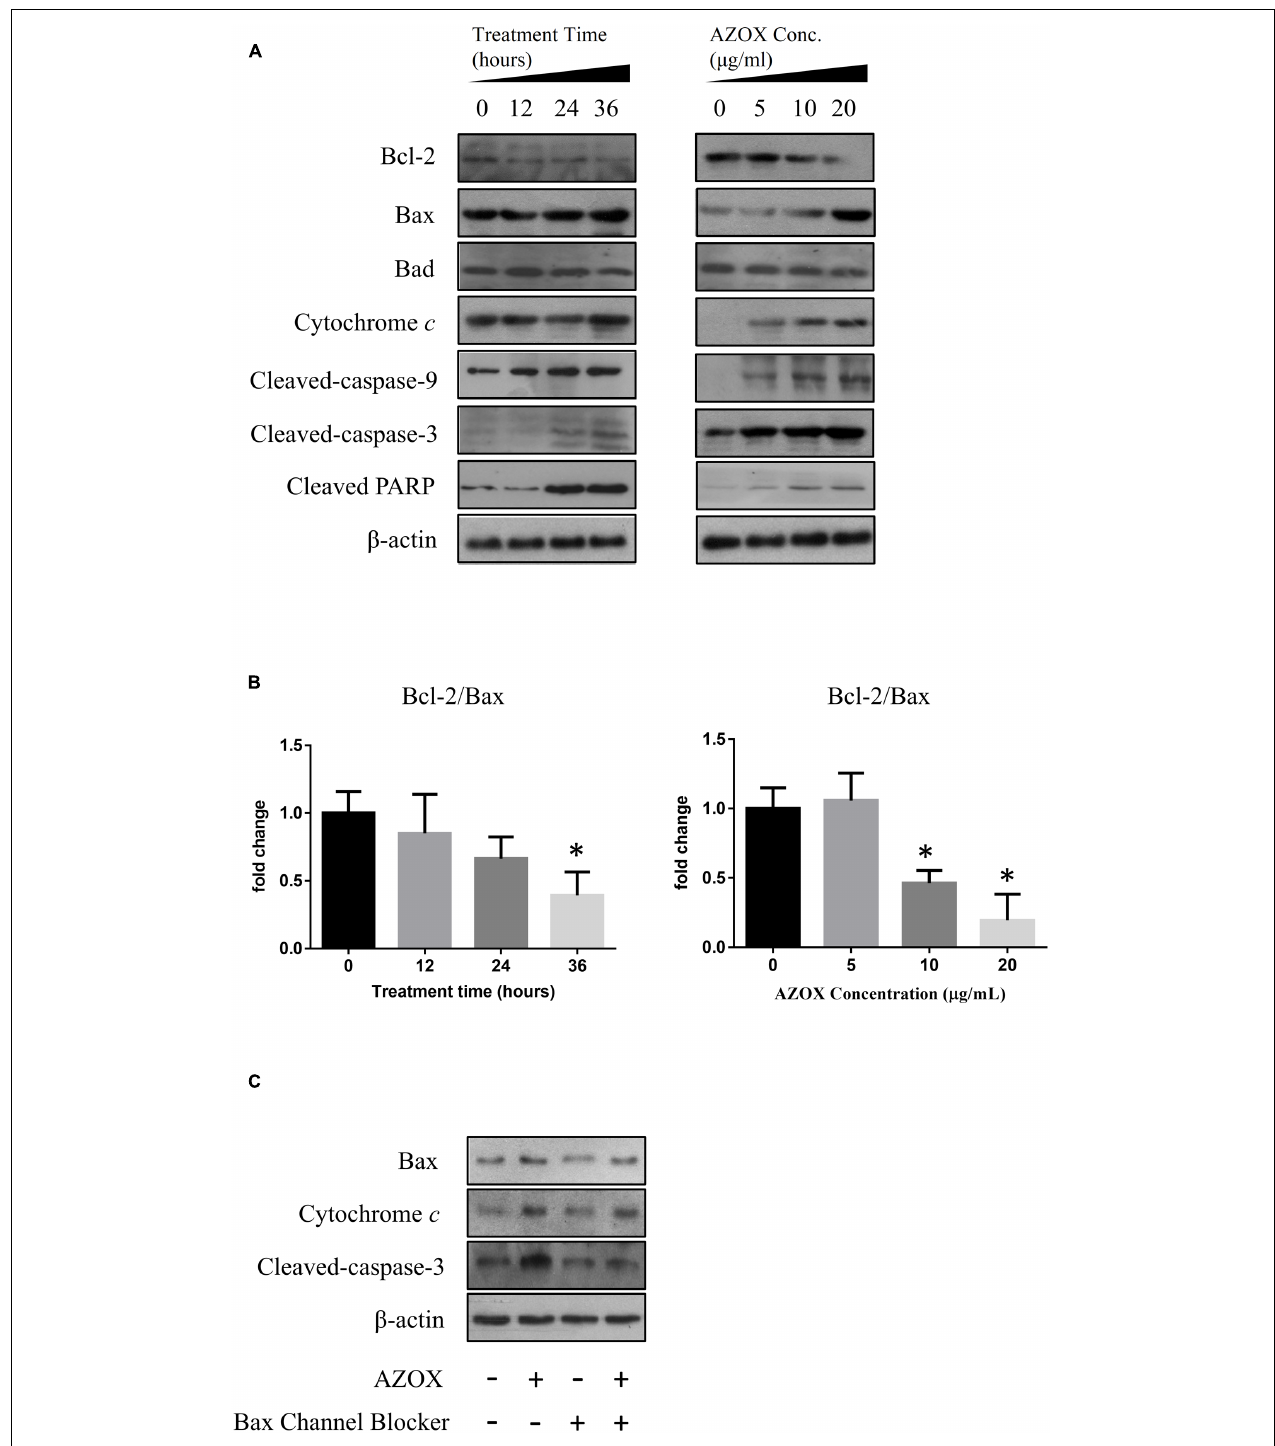
FIGURE 4 | AZOX induced KYSE-150 cell apoptosis through by activation of the intrinsic pathway. KYSE-150 cells were treated with 20 µ g/ml AZOX for 12, 24, and 36 h, respectively, or cultured in the presence of 10, 15, and 20 µ g/ml AZOX for 36 h. Cells were then washed, collected with lysis buffer, and subjected to SDS-PAGE. (A) The expression of cleaved PARP, Bcl-2, Bax, Bad, cytochrome c , and the cleaved caspases were detected by western blot analysis. (B) Time-dependent and dose-dependent effects of AZOX on the ratio of Bcl-2/Bax. (C) KYSE-150 cells were pretreated with Bax channel blocker for 30 min, and then subjected to 36 h treatment of AZOX (20 µ g/ml). The samples were collected and detected by western blot analysis. Data are represented as means ± SEM of three independent experiments ( ∗ p < 0.05).